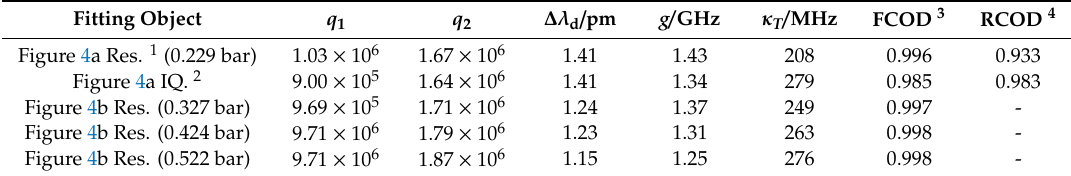
Replotted Coe ffi cient of determination (Replotted 1 Res., Resonance. 2 IQ., IQ curve. 3 FCOD, Fitting Coefficient of determination (Fitting R-Square). 4 RCOD, Replotted Coefficient of determination (Replotted R-Square).